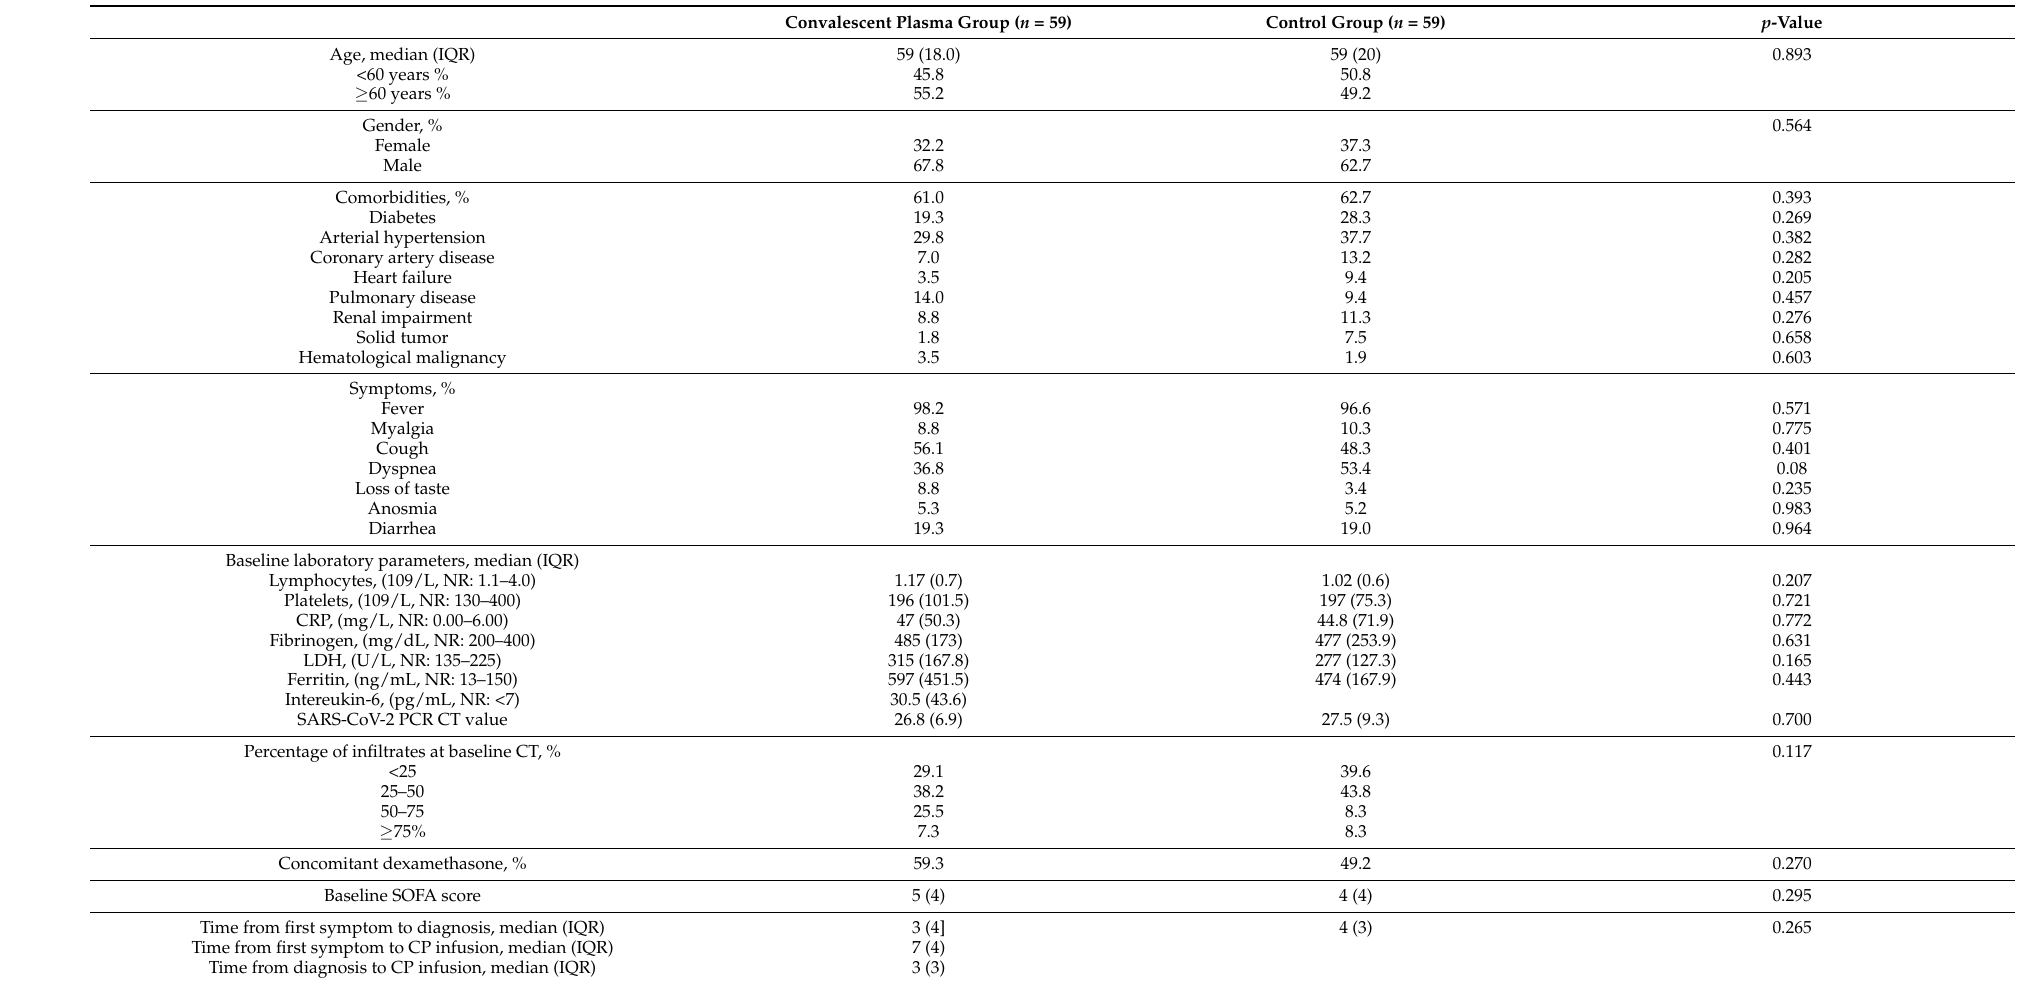
Table 1. Comparison of baseline characteristics of patients in the convalescent plasma and the control